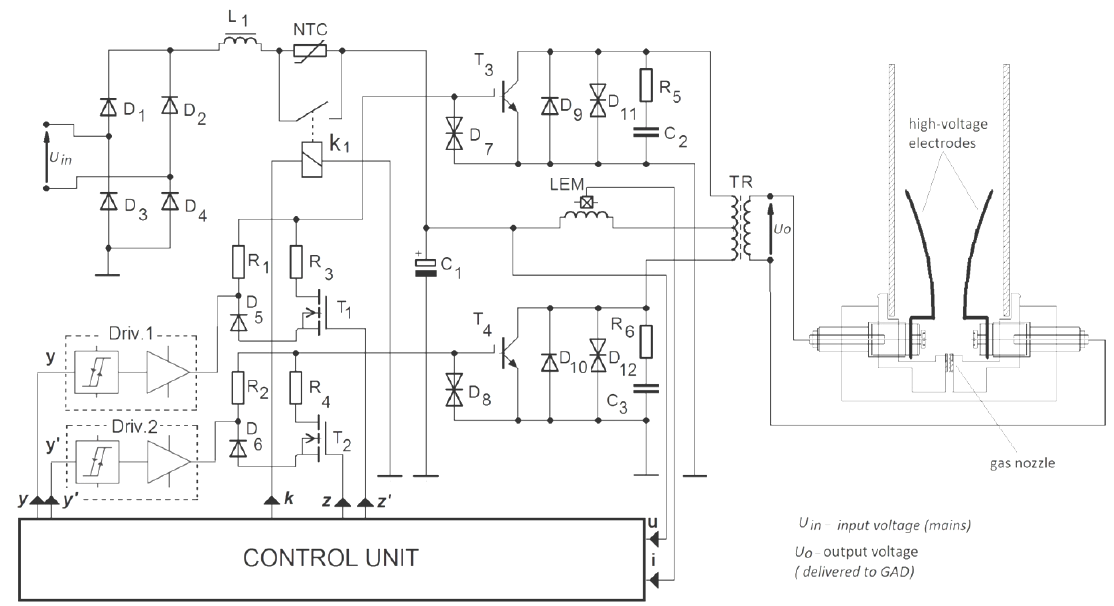
Figure 18. Simplified diagram of high-voltage pulse power supply of two electrode µ GAD plasma reactor [64].